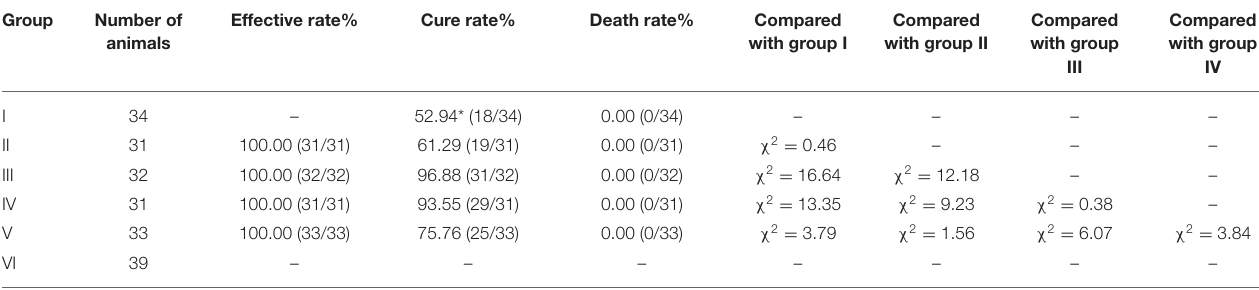
TABLE 6 | Clinical treatment effect of each group (with cure rate as evaluation index). Group Number of animals